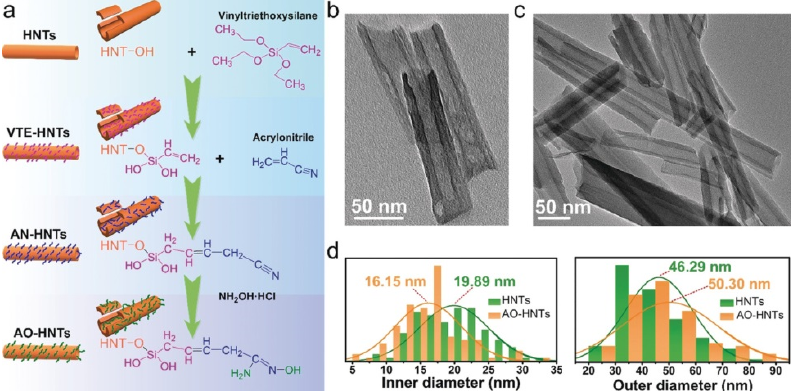
Figure 24. Functionalization of HNTs. ( a ) Illustration of the fabrication of amidoxime-HNTs; TEM images of ( b ) HNTs and ( c ) amidoxime-HNTs; ( d ) inner and outer diameter distribution of HNTs and amidoxime-HNTs. Reproduced with permission from [169].